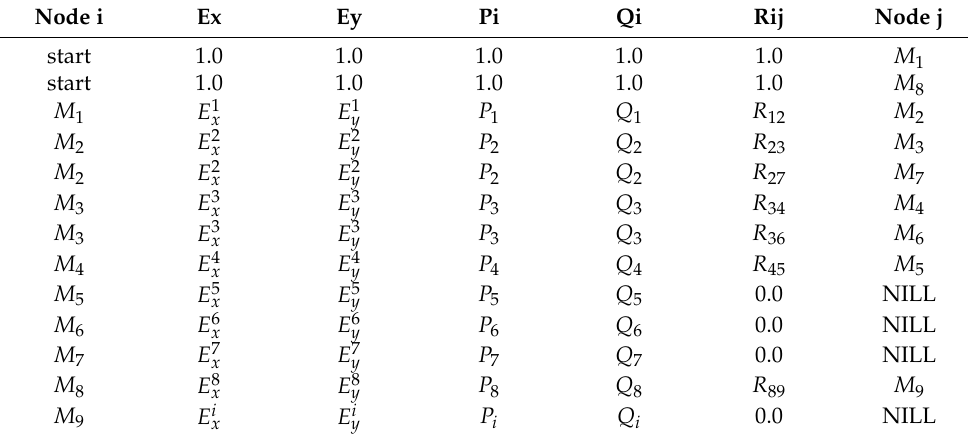
Figure 11. An example of Energy-Based Memory Network. Table 1. Memory Network List.